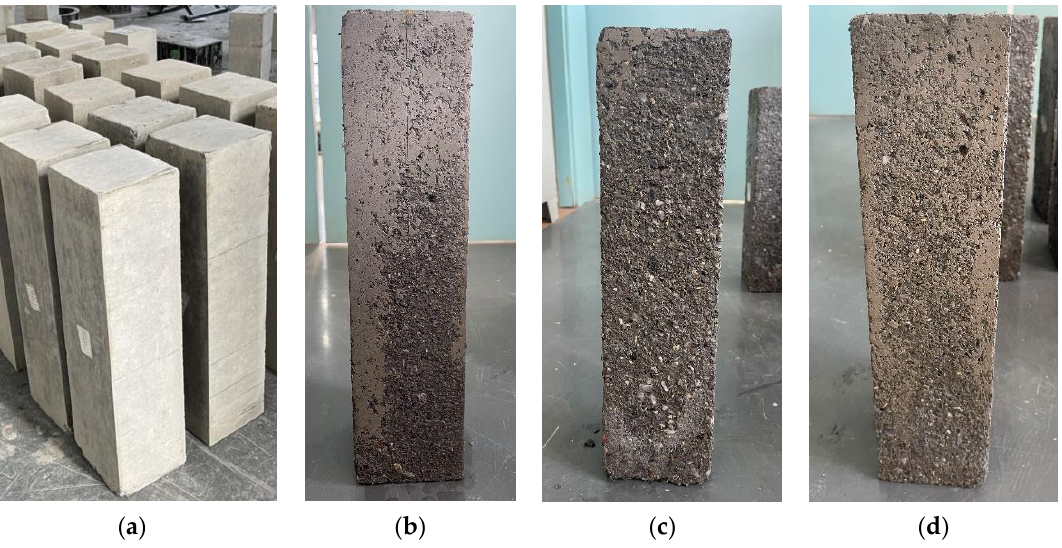
Figure 17. Appearance of concrete specimen after 250 freeze – thaw cycles: ( a ) Pre-test specimens, ( b ) C30DMS, ( c ) C30WMS, and ( d ) C30M-S.